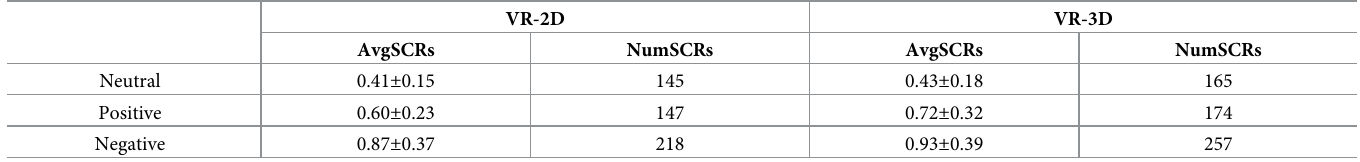
Table 3. The avgSCRs (mean ± S.D.) and numSCRs under different movie-watching modes.